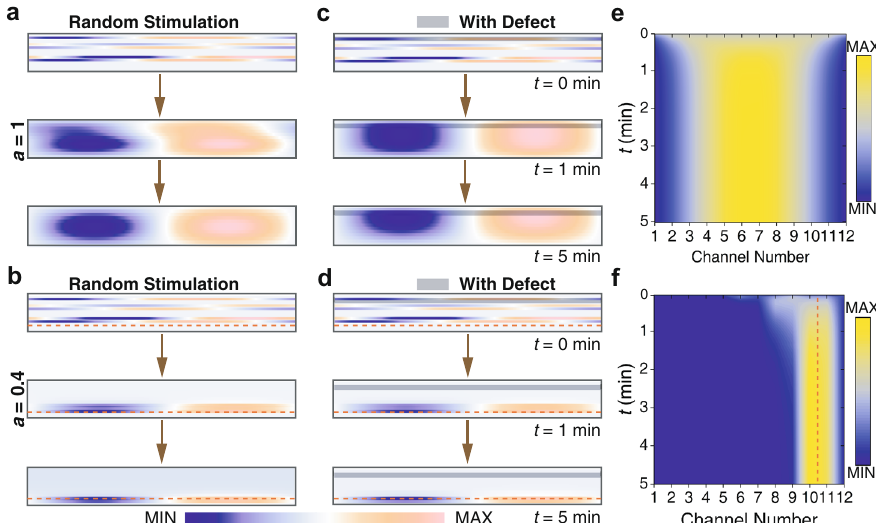
Fig. 5 Heat funneling effect. a , b Temperature fi eld evolutions with time t for random stimulations at the symmetric coupling ( a = 1) and the asymmetric coupling ( a = 0.4), respectively. Blue color and twilight color indicate the minimum temperature and the maximum temperature. c , d Temperature fi eld evolutions with an introduced asymmetric coupling defect between channels 2 and 3 for the cases in ( a ), ( b ). e , f Normalized strength evolutions of (cid:9) (cid:9) (cid:9) (cid:9) 2 ) for a uniform stimulation at a = 1 and a = 0.4, where the concept of heat funneling in Fig. 1b is proved. Blue color and yellow temperature intensity ( T grad color indicate the minimum temperature intensity and the maximum temperature intensity, respectively. The red dashed lines denote the